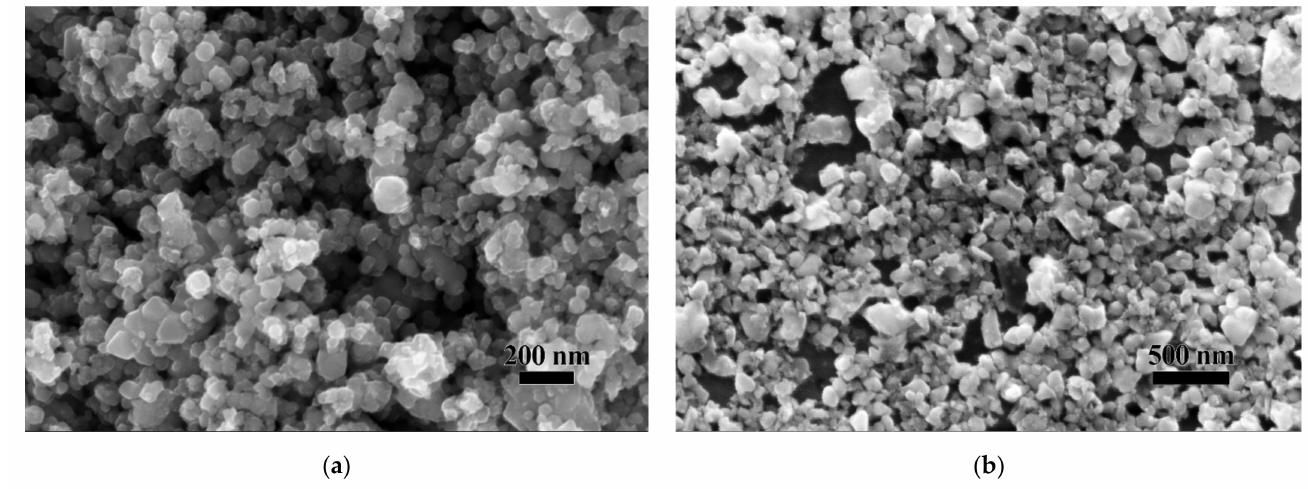
Figure 1. FESEM images of ( a ) the as-obtained nano TiC powders and ( b ) the prepared WO 3